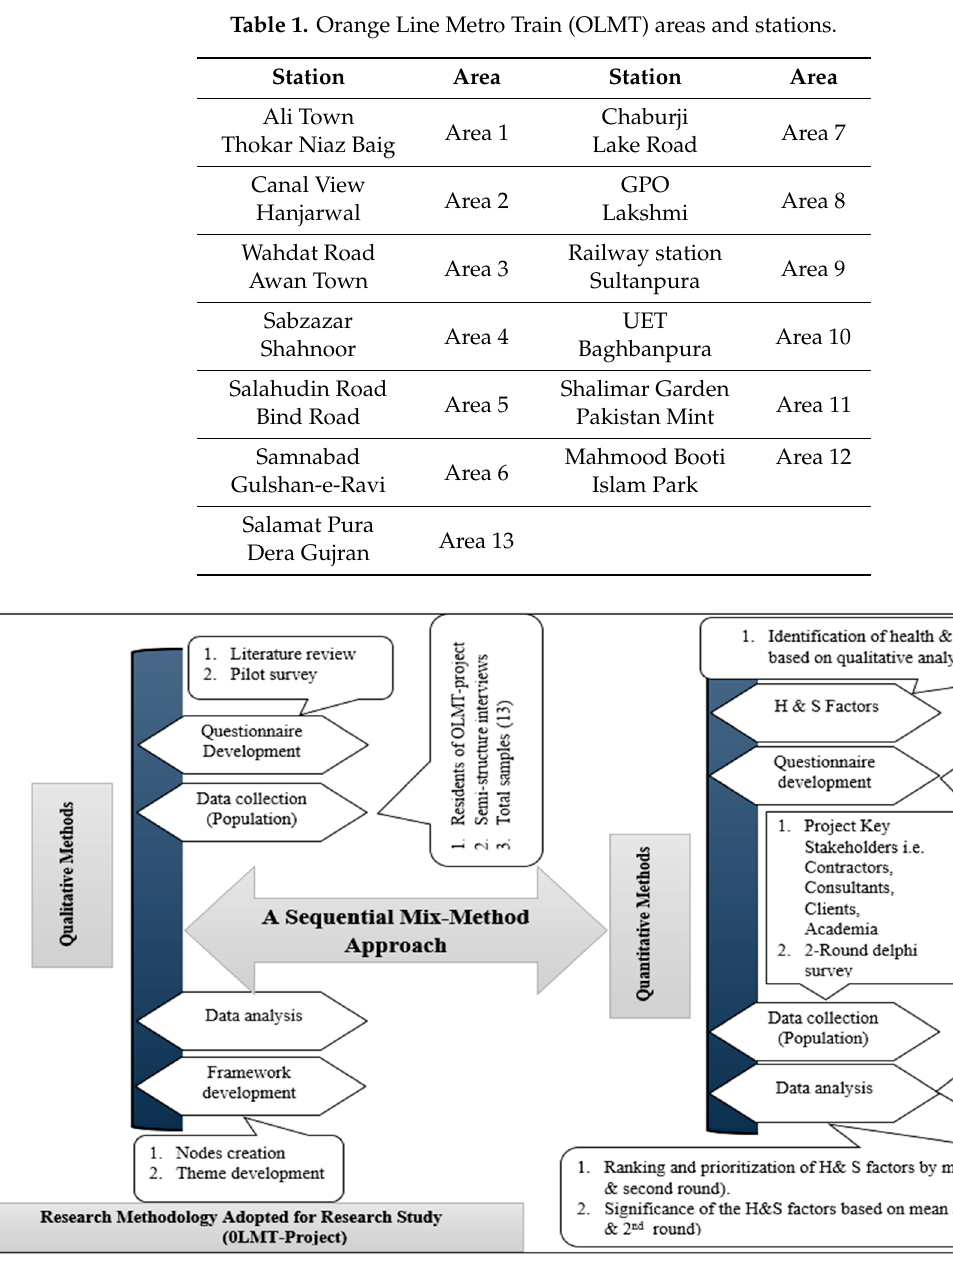
Figure 1. Research Methodology adopted for (OLMT) study.